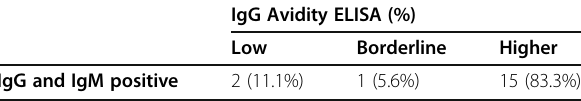
Table 2 Comparison of results of IgM ELISA with IgG avidity test in 18 serum samples taken from pregnant women in